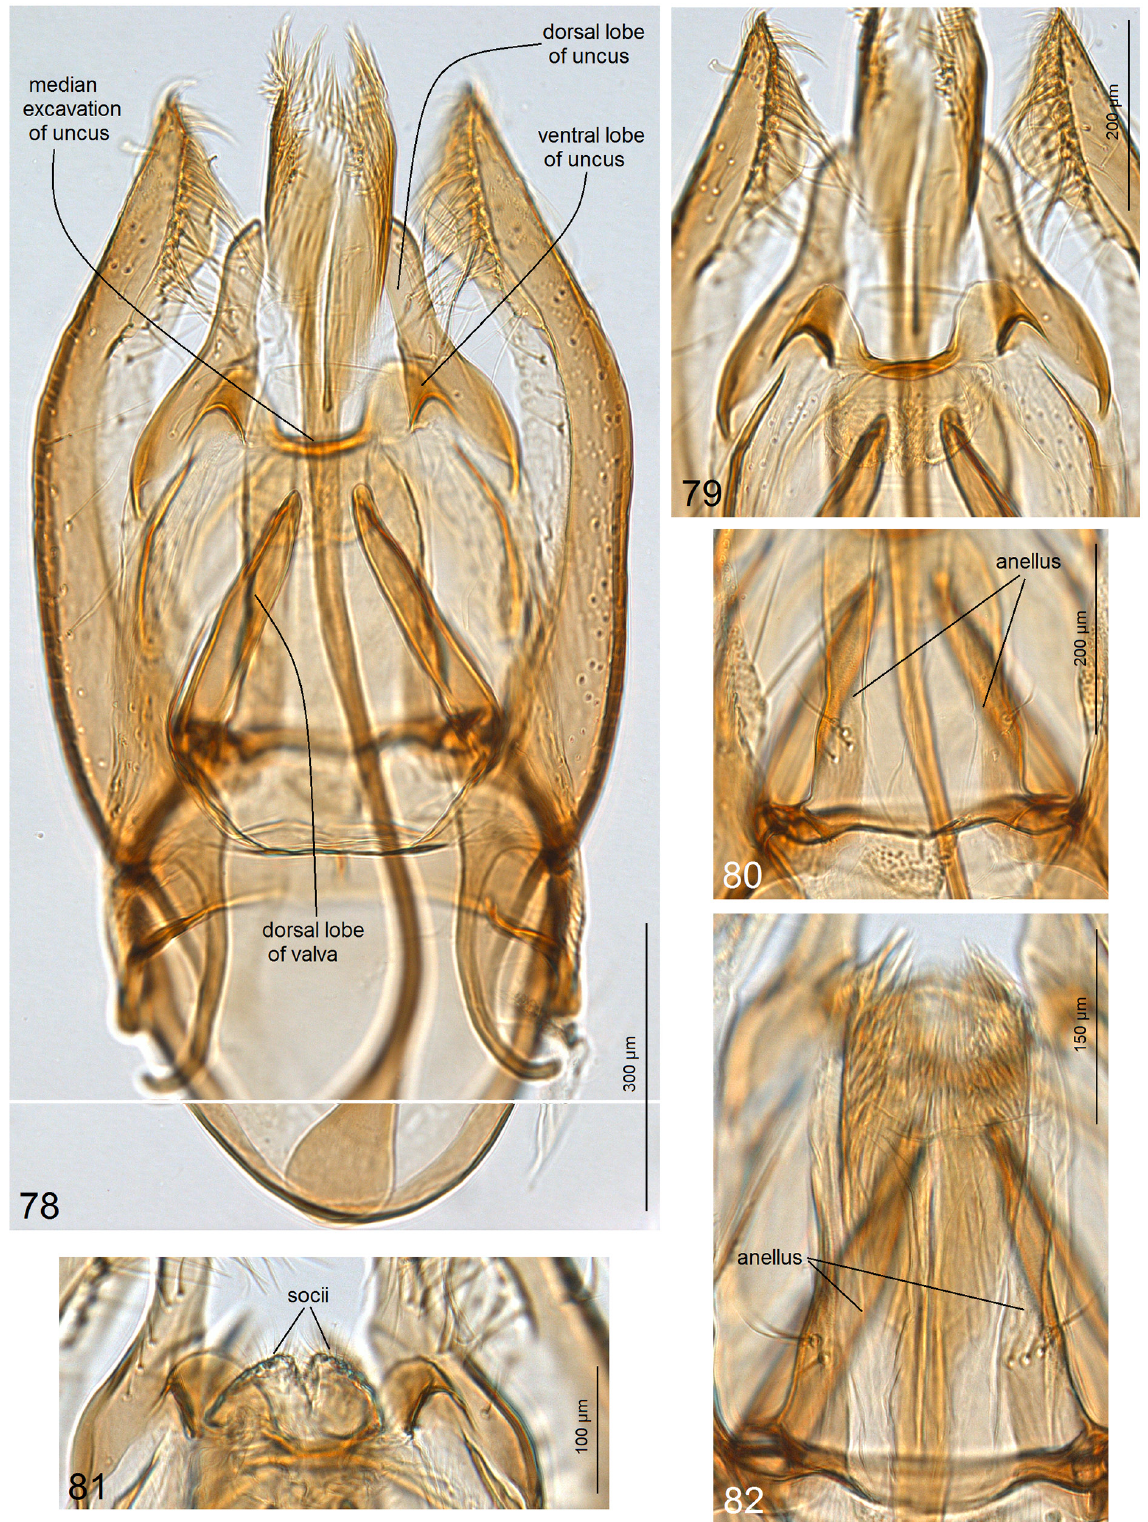
Figs 78–82. Male genitalia of Astrotischeria basilobata Remeikis & Stonis sp. nov. (NHMUK). 78 . Capsule, with phallus inside, paratype (genitalia slide no. 010316195). 79 . Same, ventral lobe of uncus. 80 . Same, anellus. 81 . Socii, holotype (genitalia slide no. 010316194). 82 . Same, 50